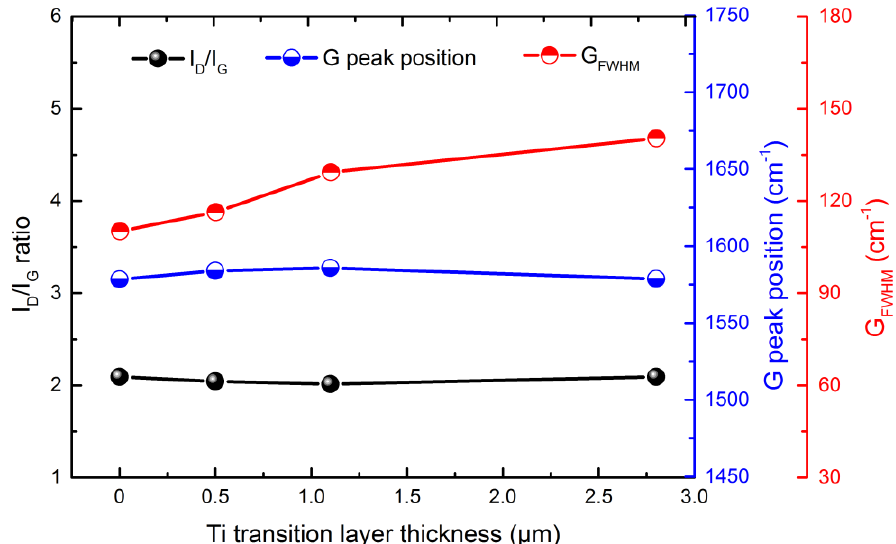
Figure 6. Corresponding I D /I G ratio, G peak position and G FWHM of Ti-DLC coatings with Ti transition layer thickness ( t 0 ): ( a ) 0 μm, ( b ) 0.5 μm, ( c ) 1.1 μm and ( d ) 2.8 μm.